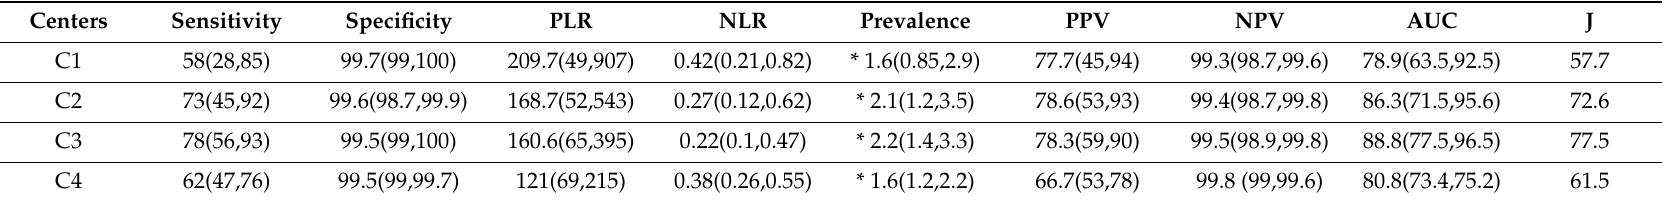
Table 3. Summary of results across the five centers at 95% Confidence